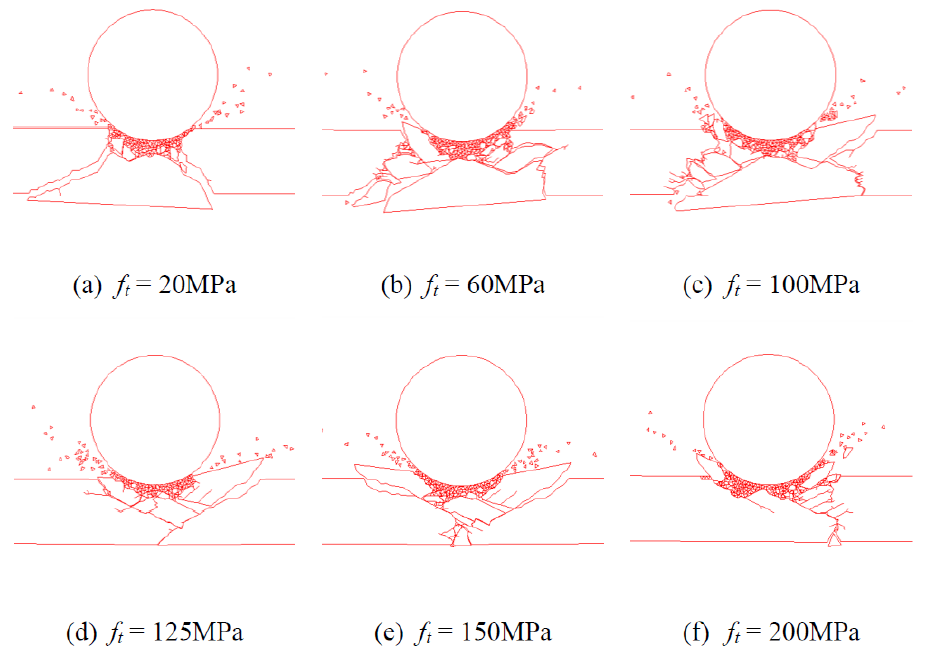
Figure 20. Fracture patterns of the glass with α = 90°, v = 5 m/s and different f t at t = 1 ms. Table 7. Impact failure modes at v = 5 m/s with different tensile strengths of glass.